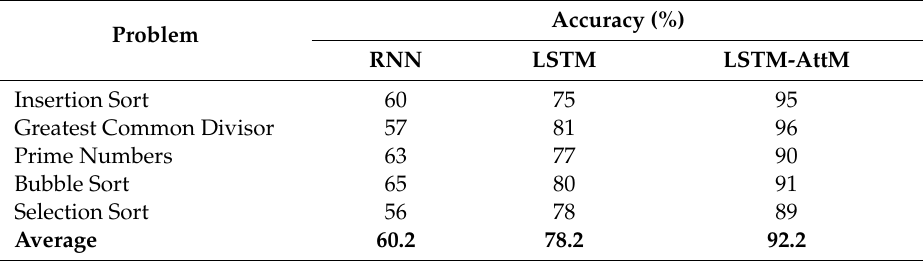
Table 6. Assessment results of logic error detection for erroneous source code.